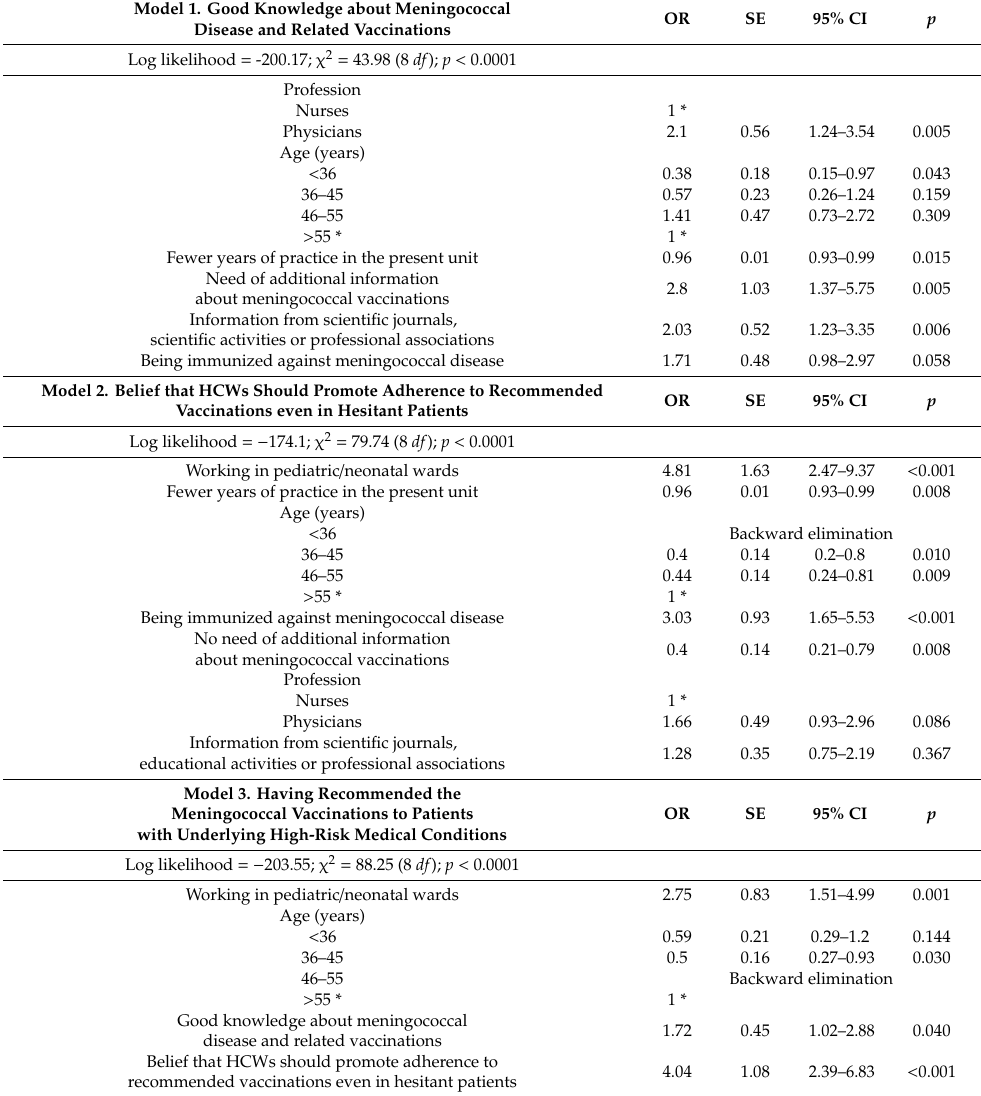
Table 2. Multivariate logistic regression analyses to characterize factors associated with the outcomes of